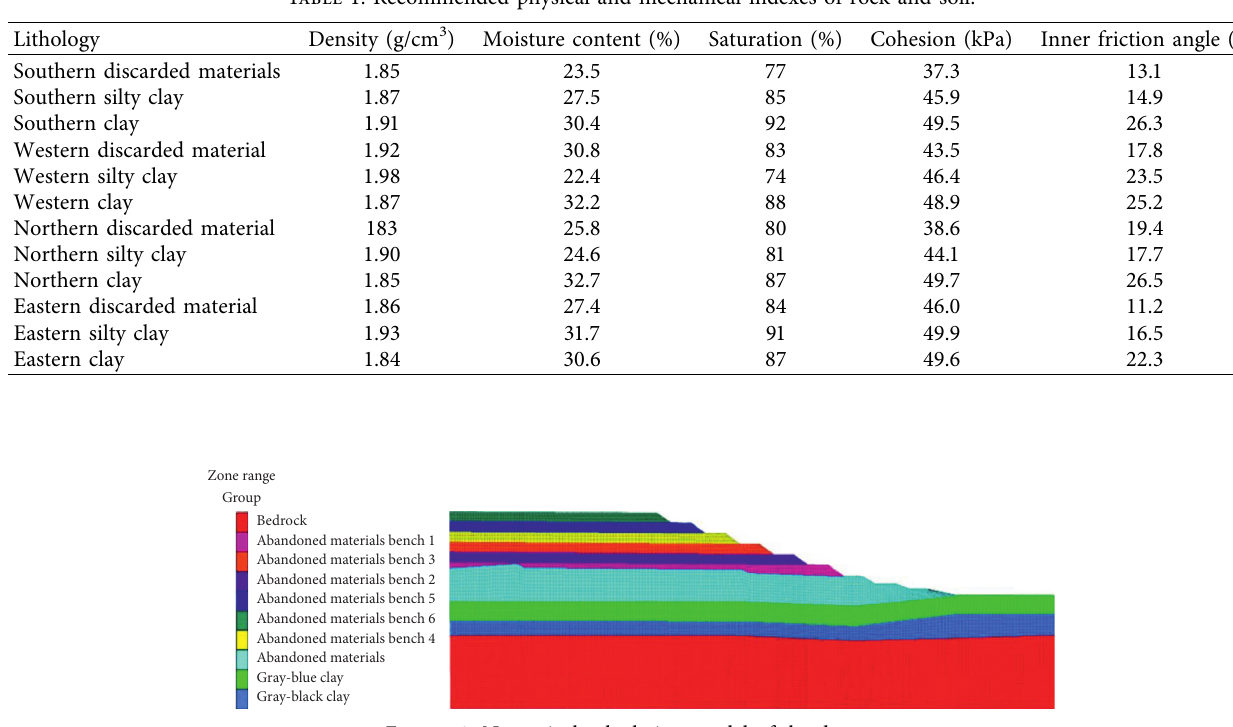
Table 1: Recommended physical and mechanical indexes of rock and soil.